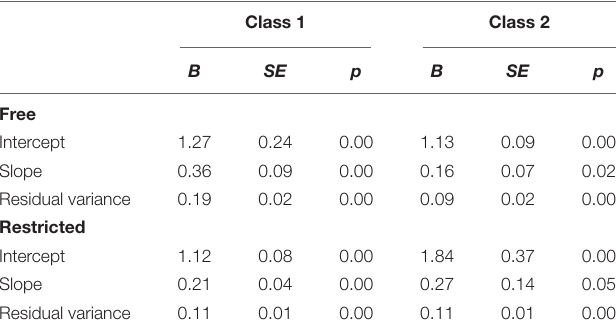
TABLE 8 | Parameter estimates, standard errors for 2-class models of free and restricted models of data-application